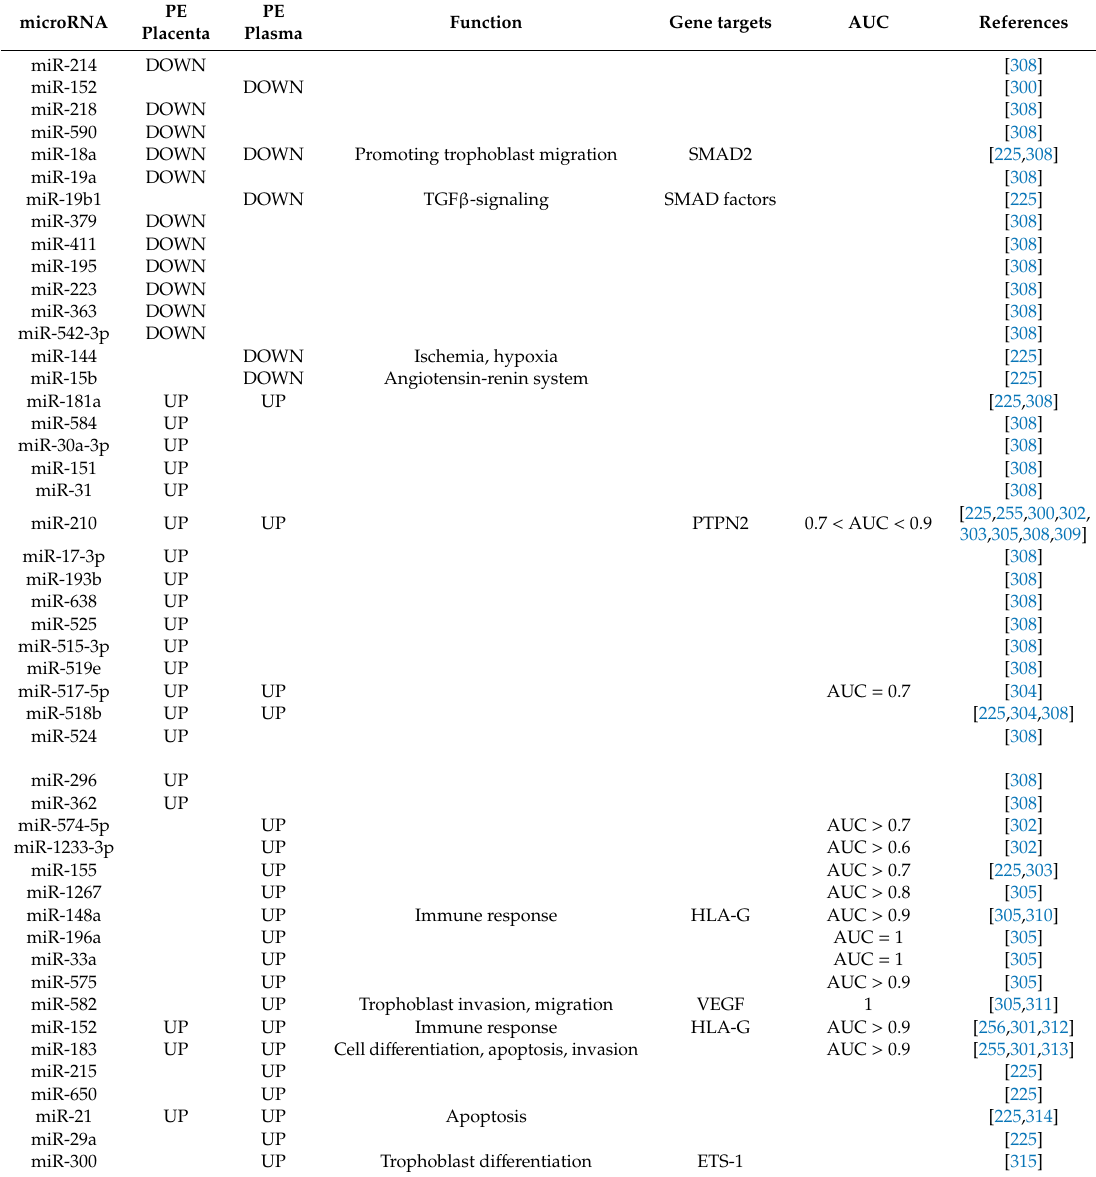
Table 4. Deregulated miRNA in